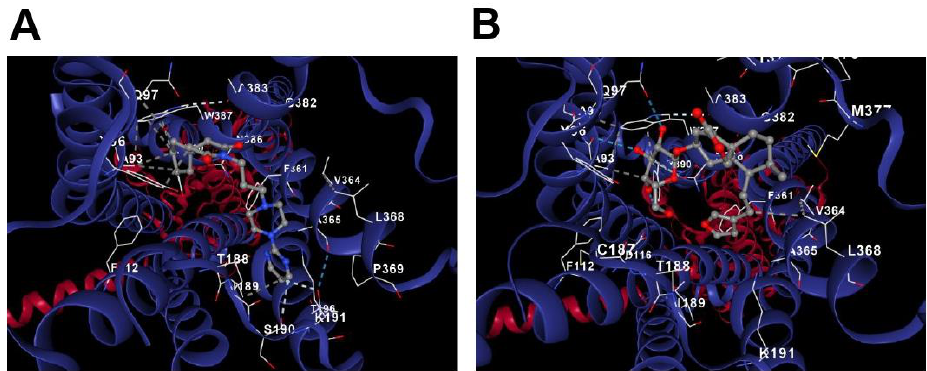
Figure 6. In silico evaluation of the interaction of buspirone or amarisolide A in the 5-HT 1A receptor. ( A ) Buspirone and 5-HT 1A receptor. ( B ) Amarisolide A and 5-HT 1A receptor. It is observed that in the amarisolide A-5-HT 1A complex, 11 steric interactions were shared in comparison with buspirone–5-HT 1A complex.